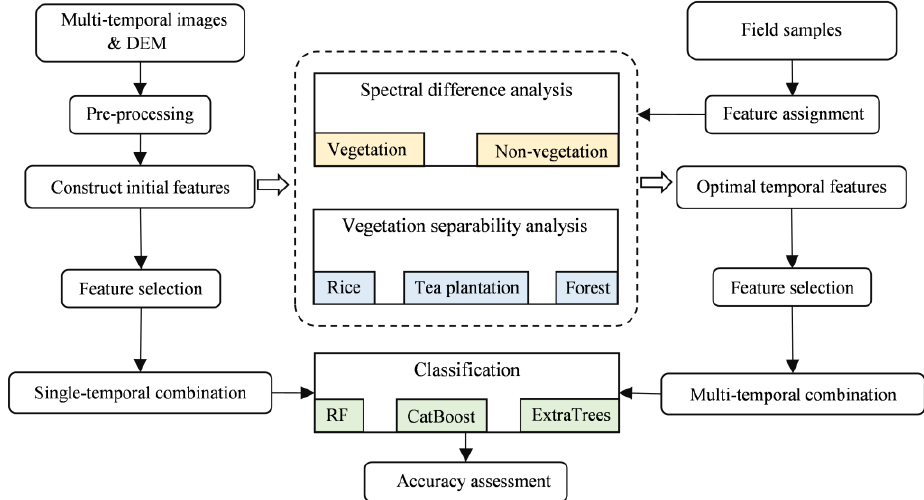
Figure 2. Flow chart of the research methodology.